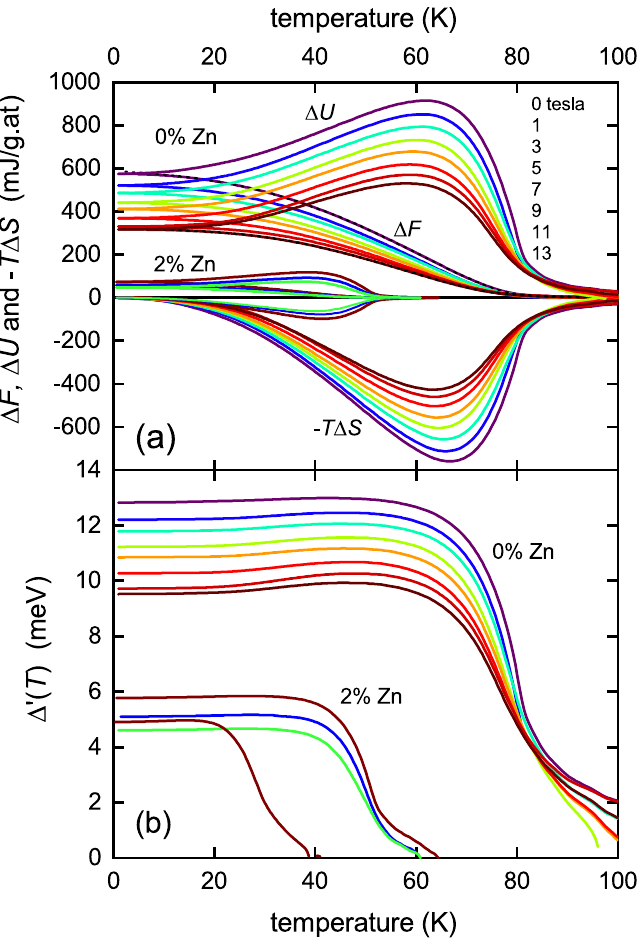
T � S ns ( T ) calculated from Figure 5. ( a ) The T -dependence of � F ns ( T ) and its components � U ns ( T ) and − γ s as given in Fig. 1. Most notable is the persistence of fluctuations high above T c in both Eq. (6) using γ n − � U ns ( T ) and T � S ns ( T ) and the almost complete suppression in � F ns ( T ) . ( b ) The superconducting order − T � S ns ( T ) using Eq. (7) for 0% and 2% Zn at fields given by the parameter, � ′ ( T ) , calculated from 2 � U ns ( T ) − colour coding in panel ( a